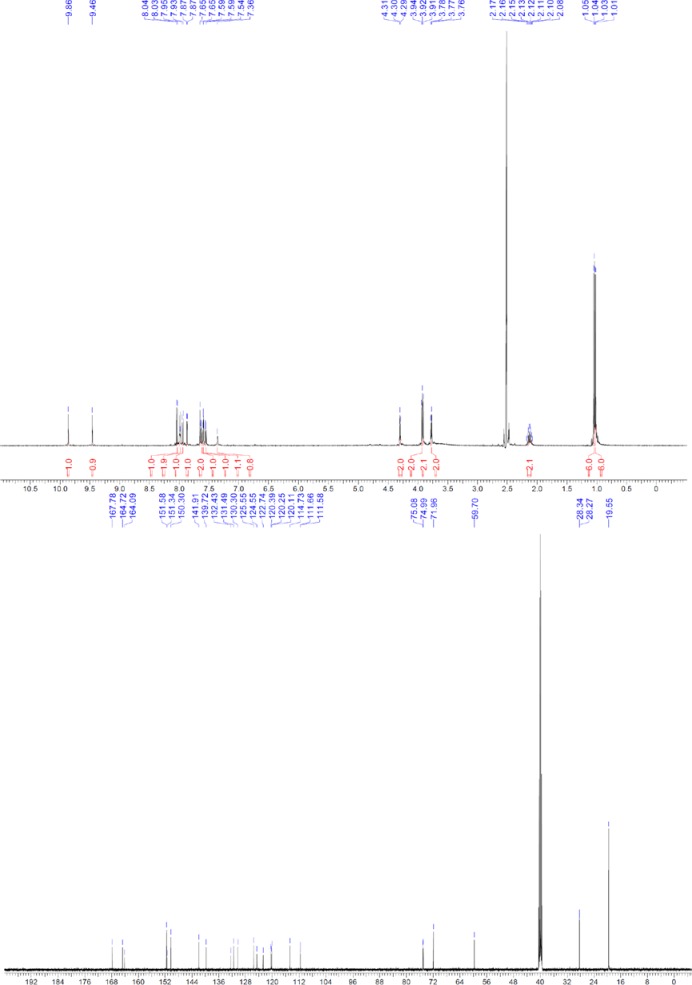
1H and 13C NMR of ERX-11.